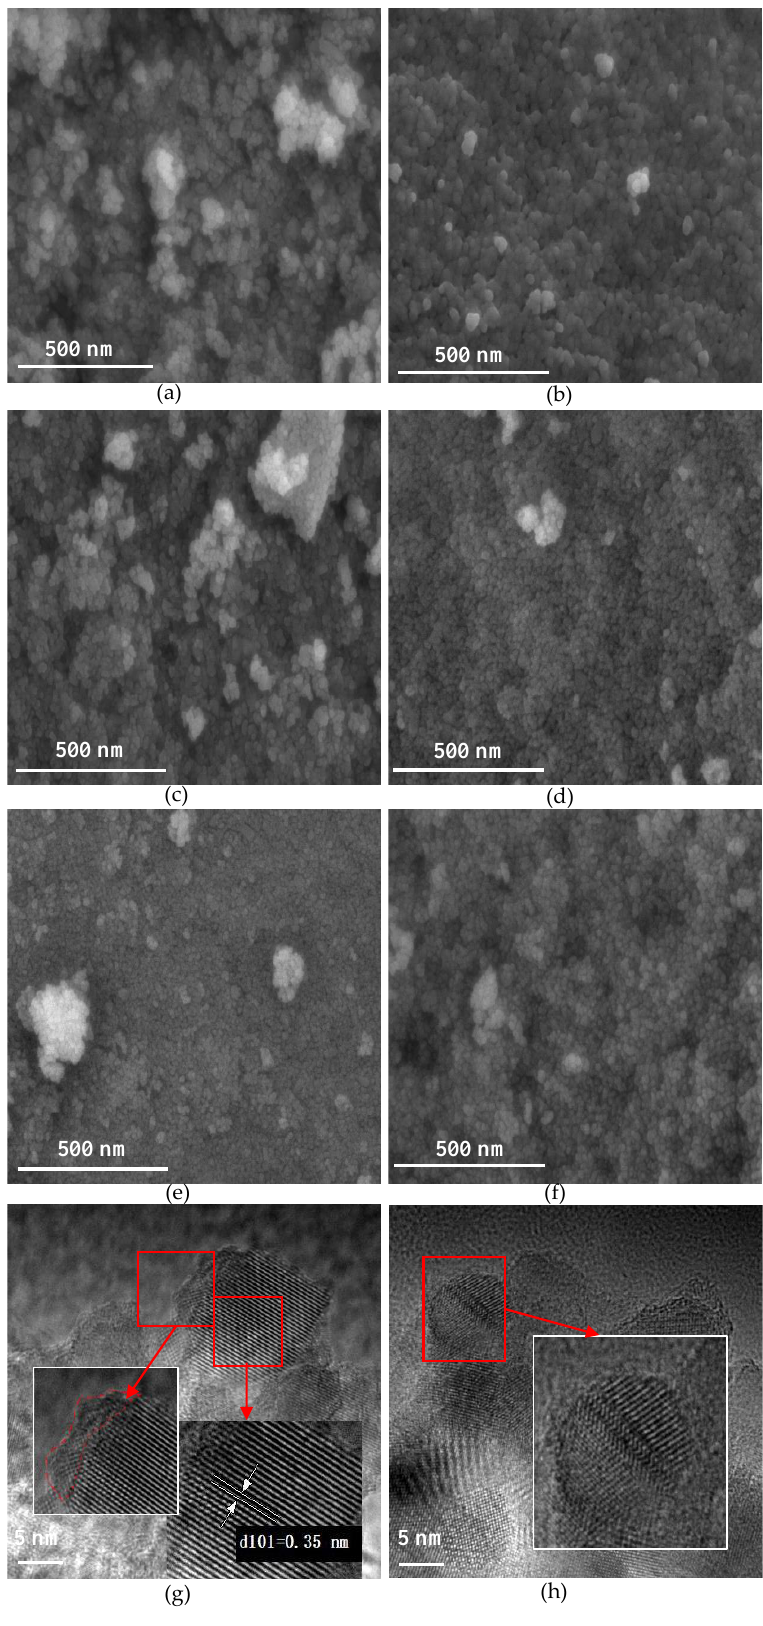
Figure 1. SEM of ( a ) T-V, ( b ) U-T-V, ( c ) T-He, ( d ) U-T-He, ( e ) T-N 2 , and ( f ) U-T-N 2 , as well as ( g , h ) HR-TEM of